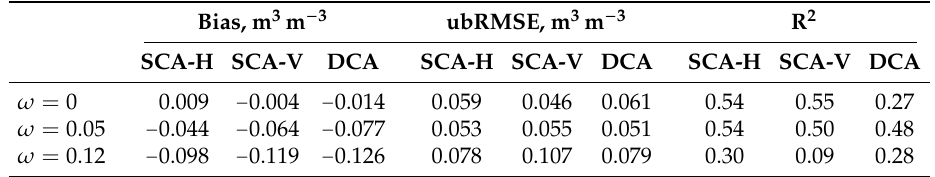
Figure 8. Comparison of raw and seven-day median L2VOD retrievals from the SPL2SMP_E product (versions 1 and 2), L2VOD retrievals using our proposed T eff , and the SMOS L2VOD during 2017 for the South Fork. Table 5. L2SM metrics in the South Fork for ω = 0, 0.05 and 0.12 during June–September,